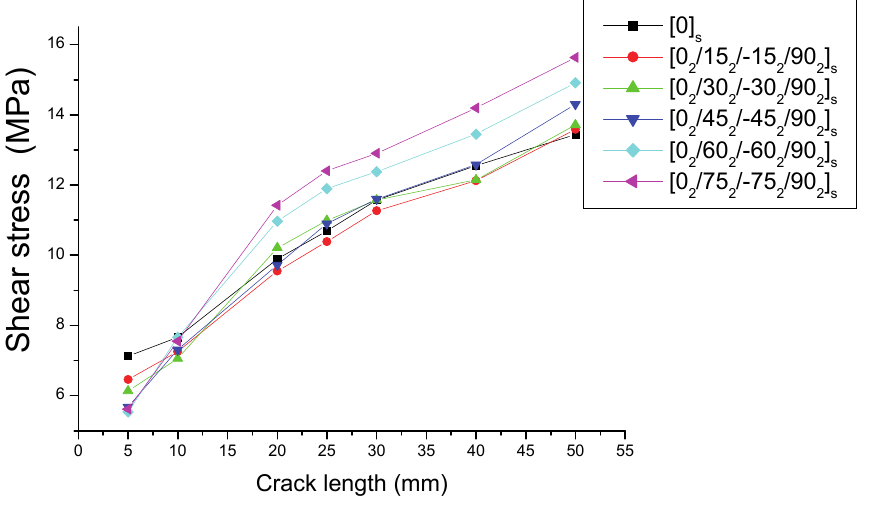
Figure 7: Variation of the adhesive Shear Stress τ 23 in function of the the length of the crack for a different sequence of stacking. The distribution of shear stresses is the same whatever the sequence of stacking in the composite. The more low stresses are for the patch with a sequence of stacking [0 8 ]s this is due to the fact that the majority of stresses in the Adhesive are absorbed by the